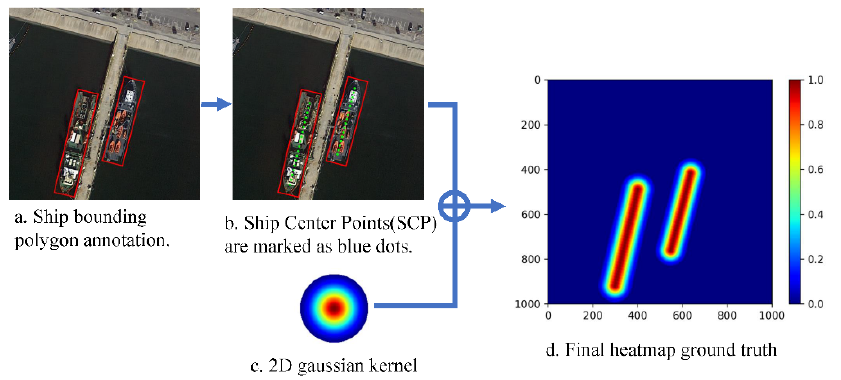
Figure 2. How the Gaussian heatmap ground truth is created.